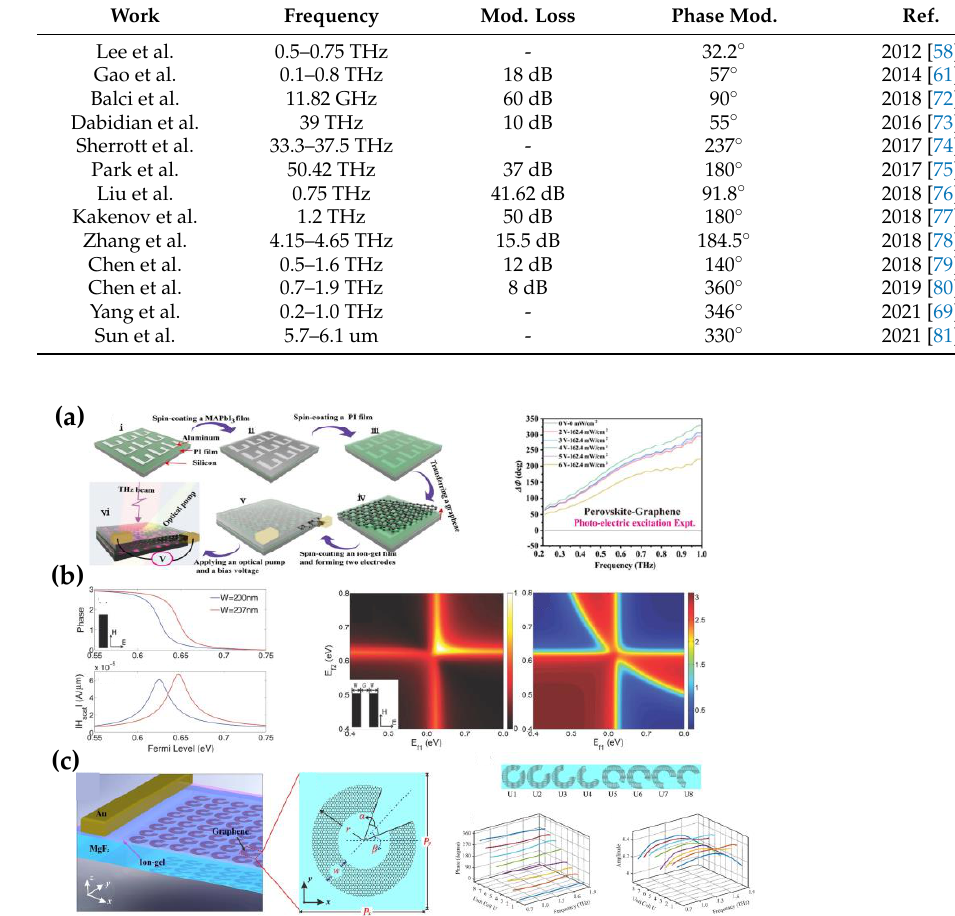
Table 2. Summary of THz phase modulators.